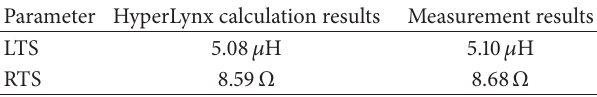
Table 1: Calculated and measured parameters of the transponder